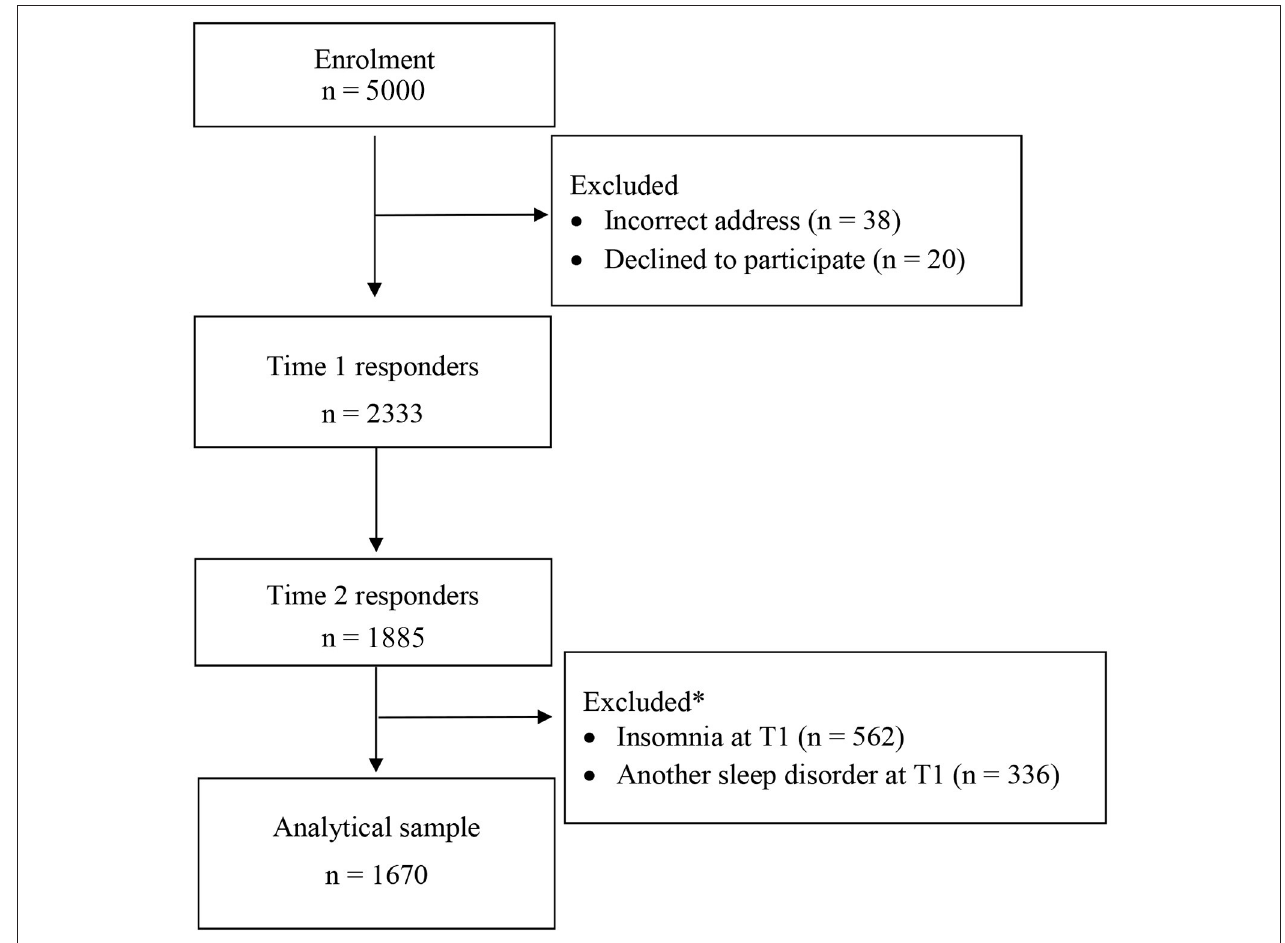
FIGURE 1 | Flow chart of recruitment into the PIPPI study. *Some excluded cases fulfilled both exclusion criteria regarding sleep disorders at Time 1.